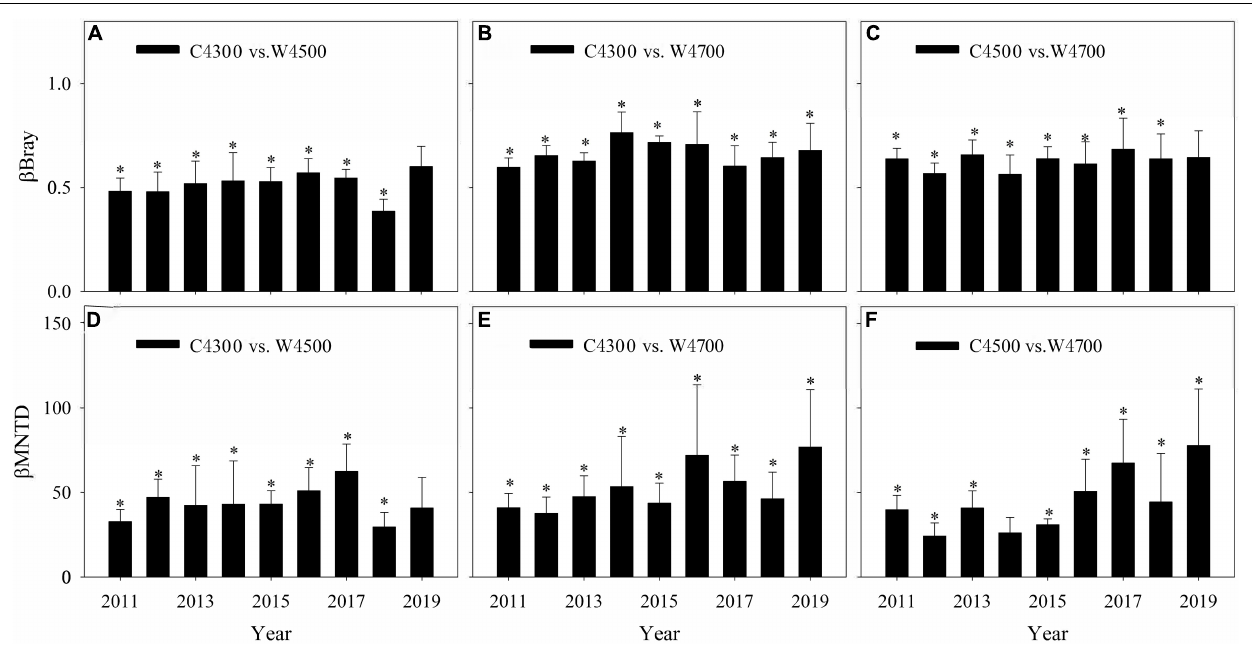
FIGURE 1 | Species β -diversity ( β Bray , A–C ) and phylogenetic β -diversity ( β MNTD, D–F ) between the control treatment at site A vs. the warming treatment at site B (C4300 vs. W4500), the C4300 treatment and the warming treatment at site C (C4300 vs. W4700), and the C4500 treatment and the W4700 treatment (C4500 vs. W4700). ∗ above bars indicates the β Bray or β MNTD of the C4300 vs. W4500, C4300 vs. W4700, and C4500 vs. W4700 were significant at p < 0.05.